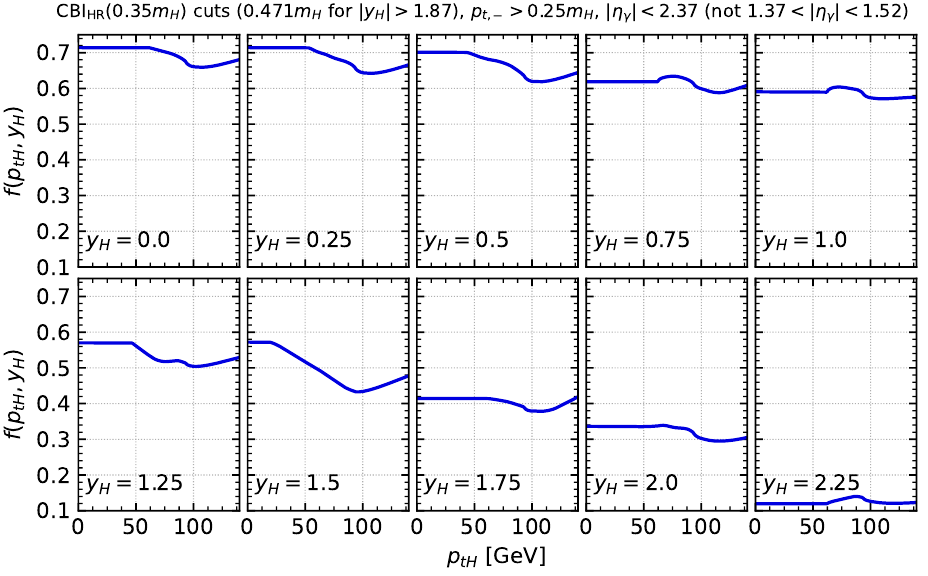
Figure 14 . Acceptance for the hardness and rapidity compensating cuts, as a function of p t, h , for several y h values (CBI HR , raised at high rapidity, as for the blue curve and the heat-map plot in the upper and lower panels respectively of figure